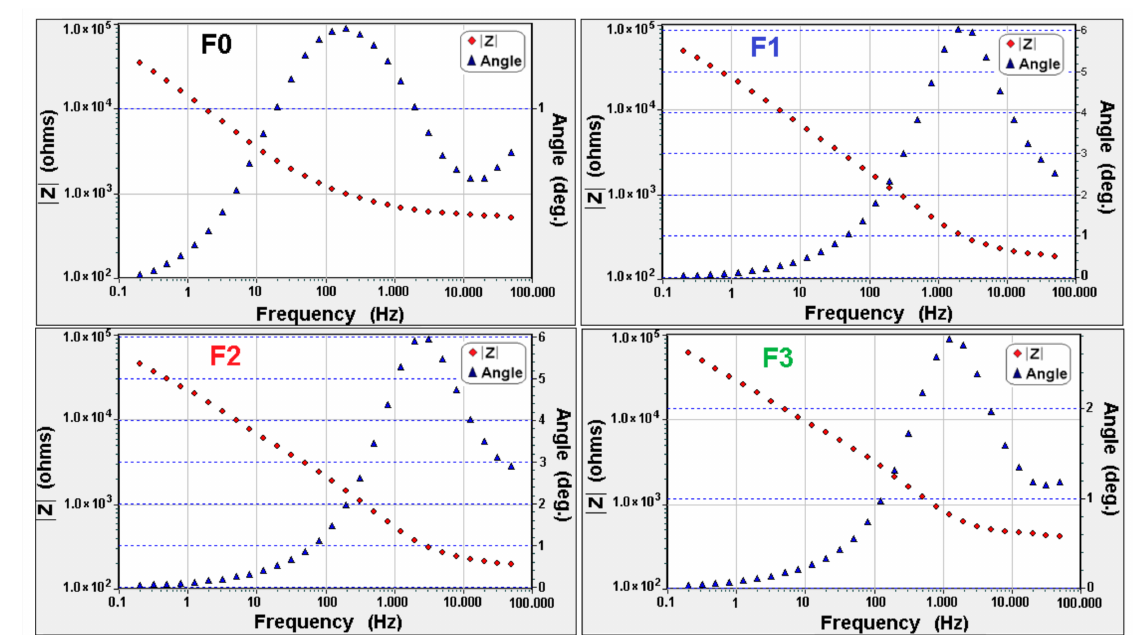
Figure 7. Bode diagrams for polymeric membranes without SiO 2 nanoparticles, before (F0) and after (F1–F3) 1 h of treatment.